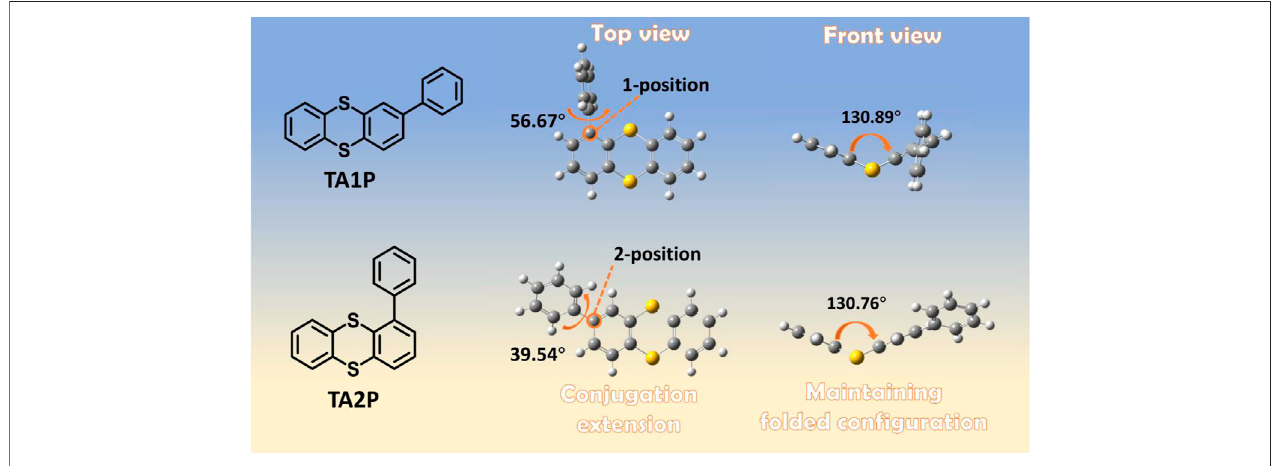
SCHEME 1 | Chemical structures and molecular geometries of TA1P and